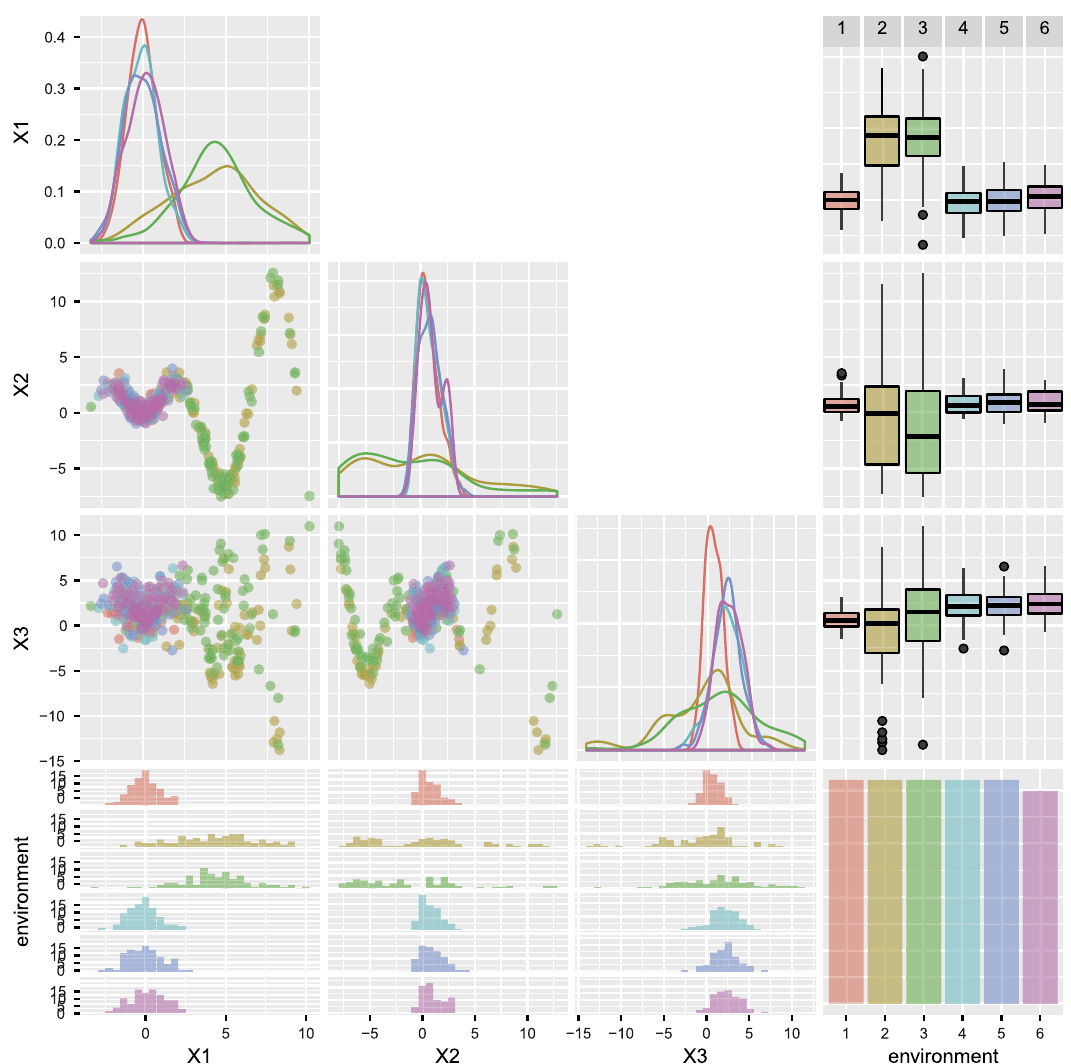
Figure 14: Visualization of the sample considered in the example in Section